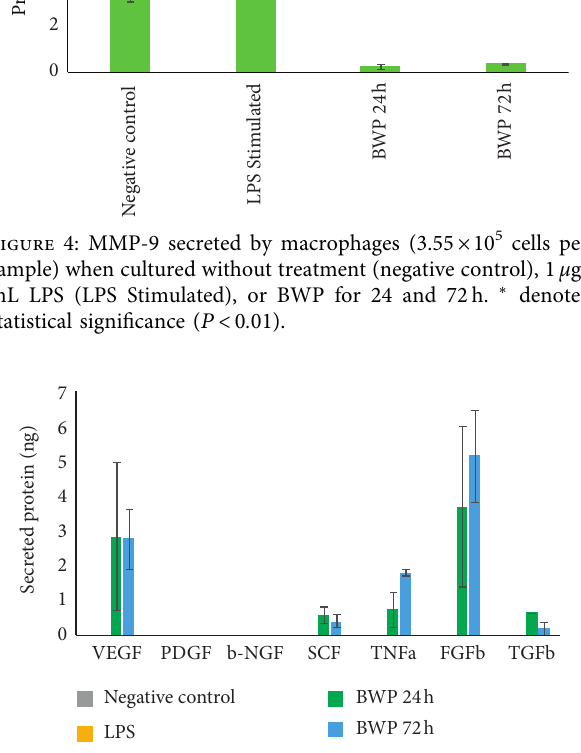
Figure 5: Levels of growth factors secreted by primary human dermal fibroblasts (2.5 × 10 5 cells per sample). Assay detection range: